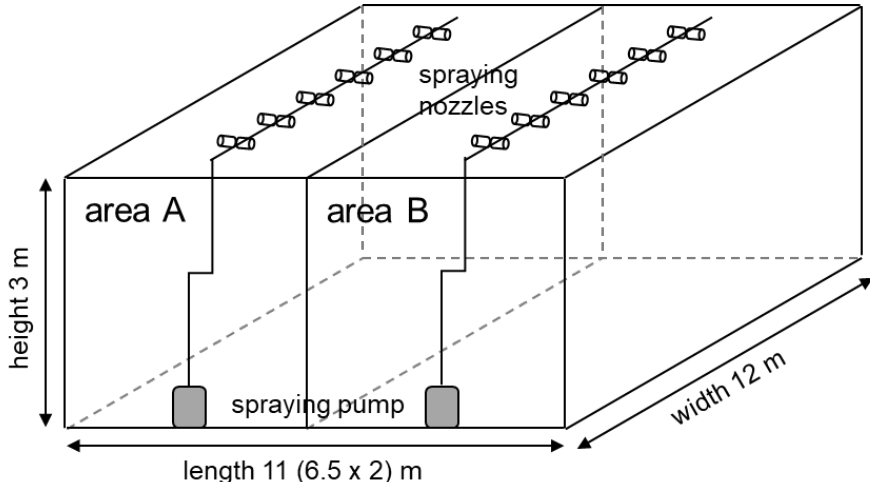
Figure 1. Design of the greenhouse used in this study.